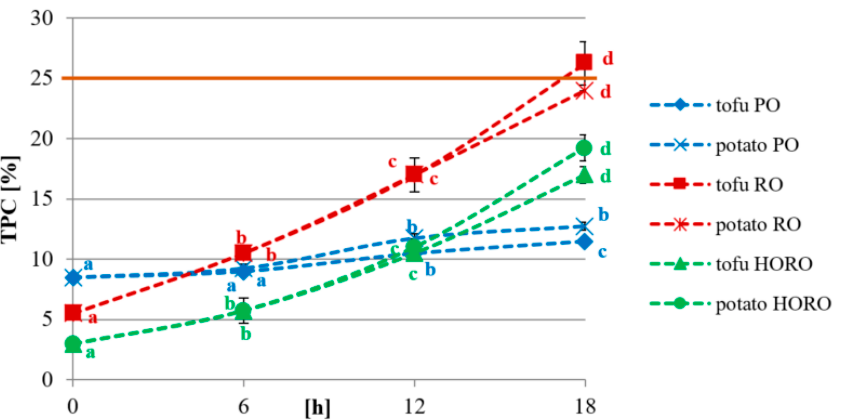
Figure 6. Changes in total polar compounds [%] of tested oils during frying of tofu or potatoes. PO—palm olein; RO—cold pressed rapeseed oil; HORO—cold pressed high oleic rapeseed oil. The values for the specific oil and type of fried product with different letters (a, b, c, d) are significantly different ( p < 0.05).